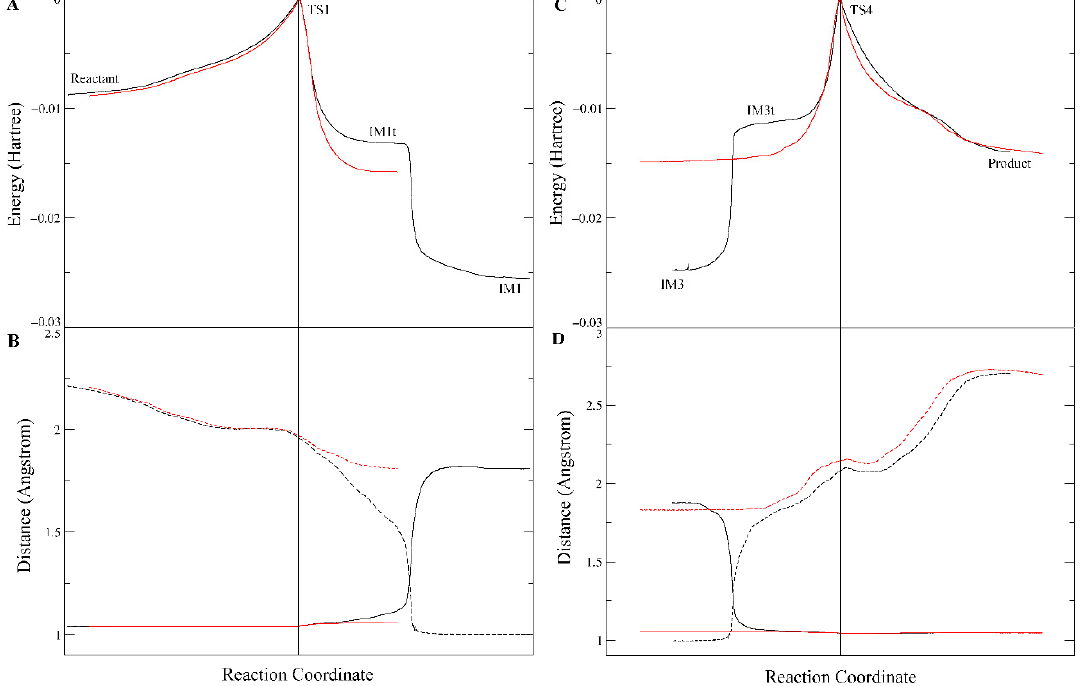
Figure 4. Intrinsic reaction coordinate of TS1 ( A , B ) and TS4 ( C , D ). ( A , C ) Changes of single point energies along the reaction coordinate; ( B , D ) Distances between cocaine N and NH (solid lines) and between carbonyl O and NH (dash lines). The red lines are the computation results with no polarization function for hydrogens, while the black ones are the normal